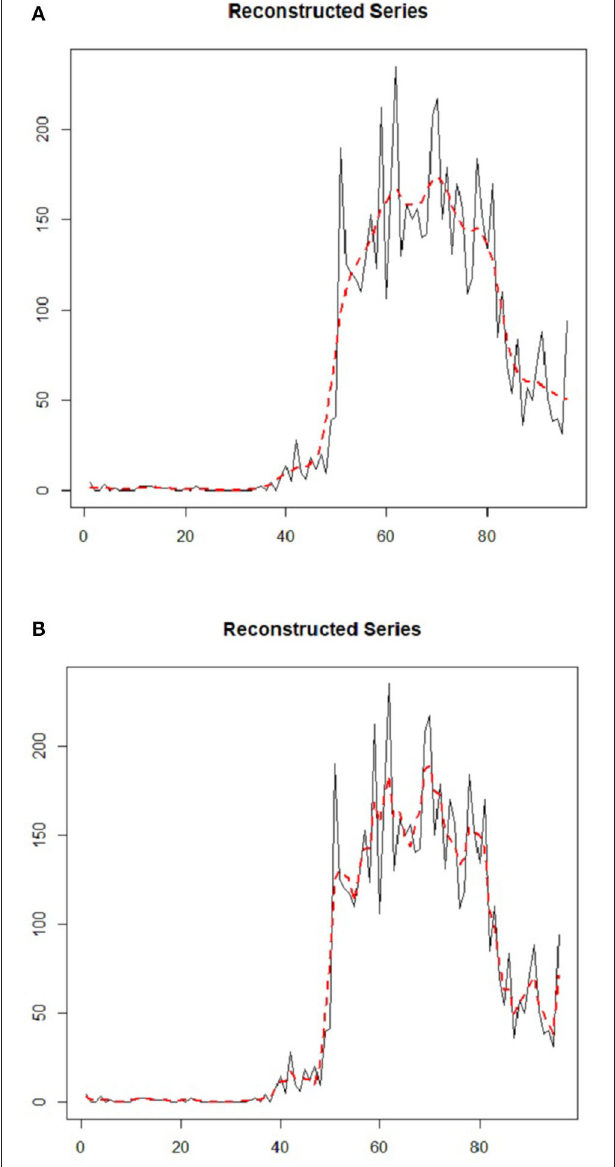
FIGURE 8 | (A,B) Daily COVID-19 cases of reconstructed components from extracted trends using SSA at (A) L